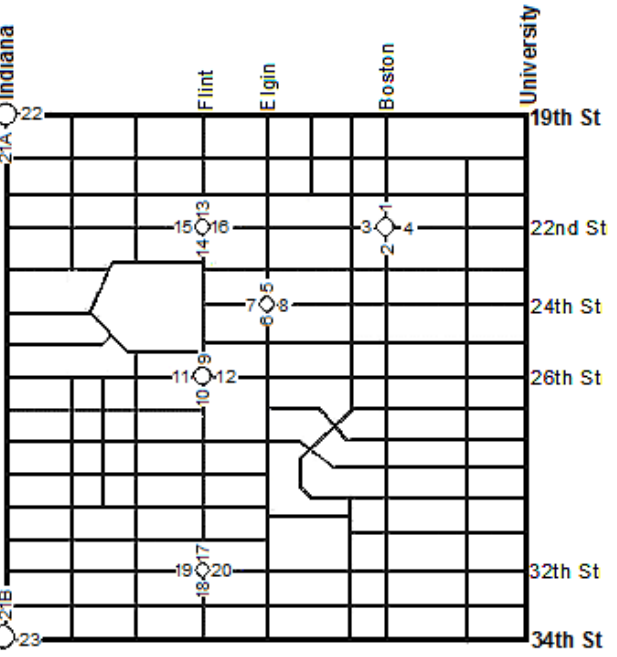
Figure 4. Tech Terrace, Lubbock, Texas (source: Paul, 2009). The traffic counts of the selected roadway units (numbered in the map) are reported in Table